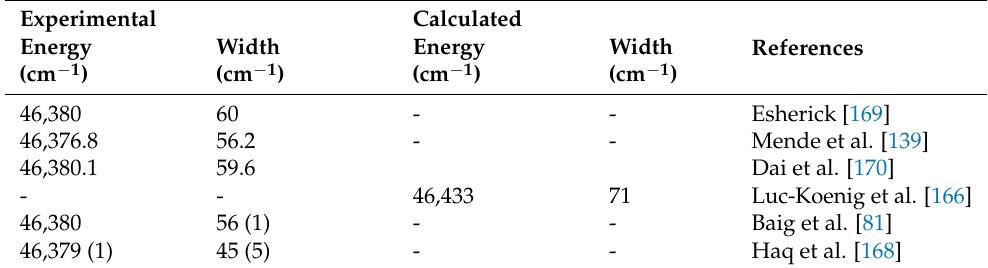
Table 6. Comparison of the resonance energy and width of the (4d 2 + 5p 2 ) 1 D 2 autoionizing